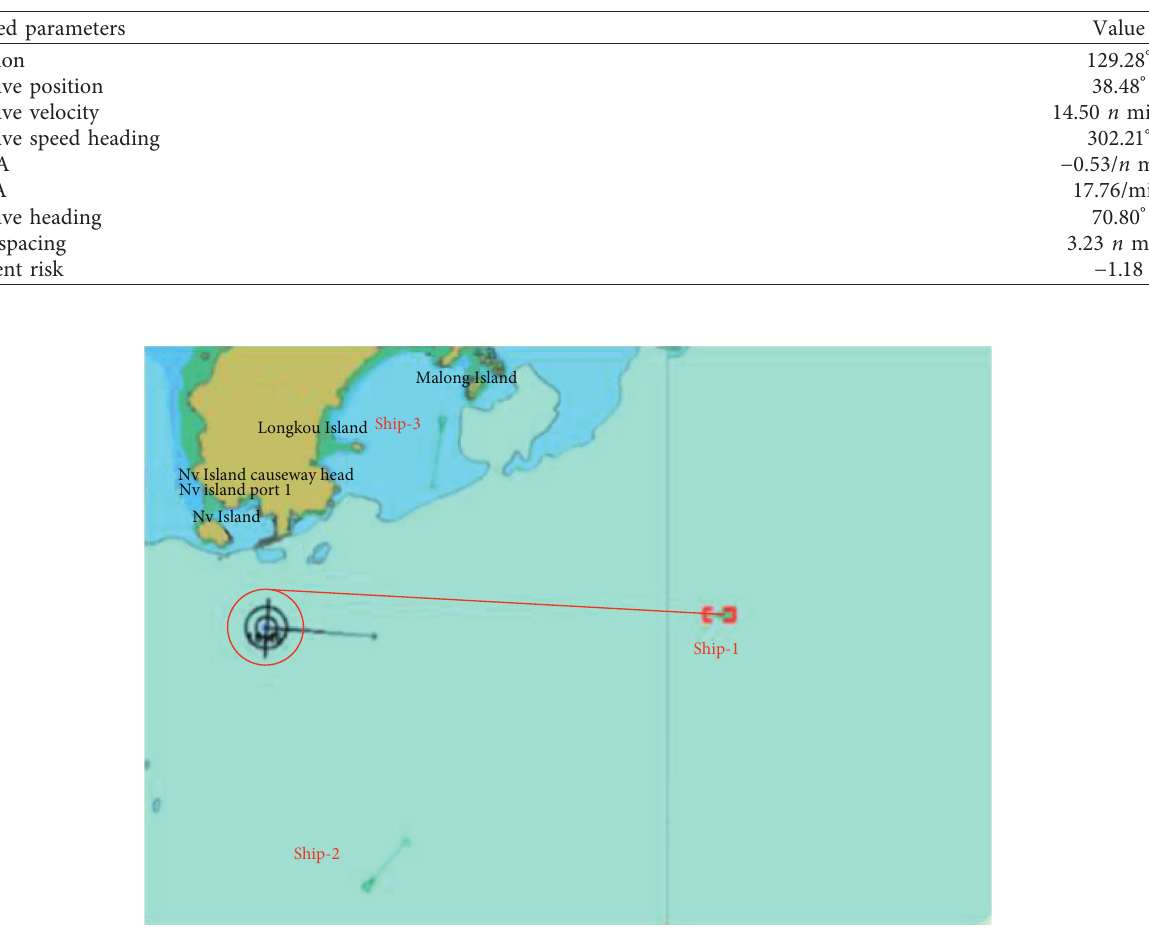
Table 5: Cross-encounter scene experimental data.